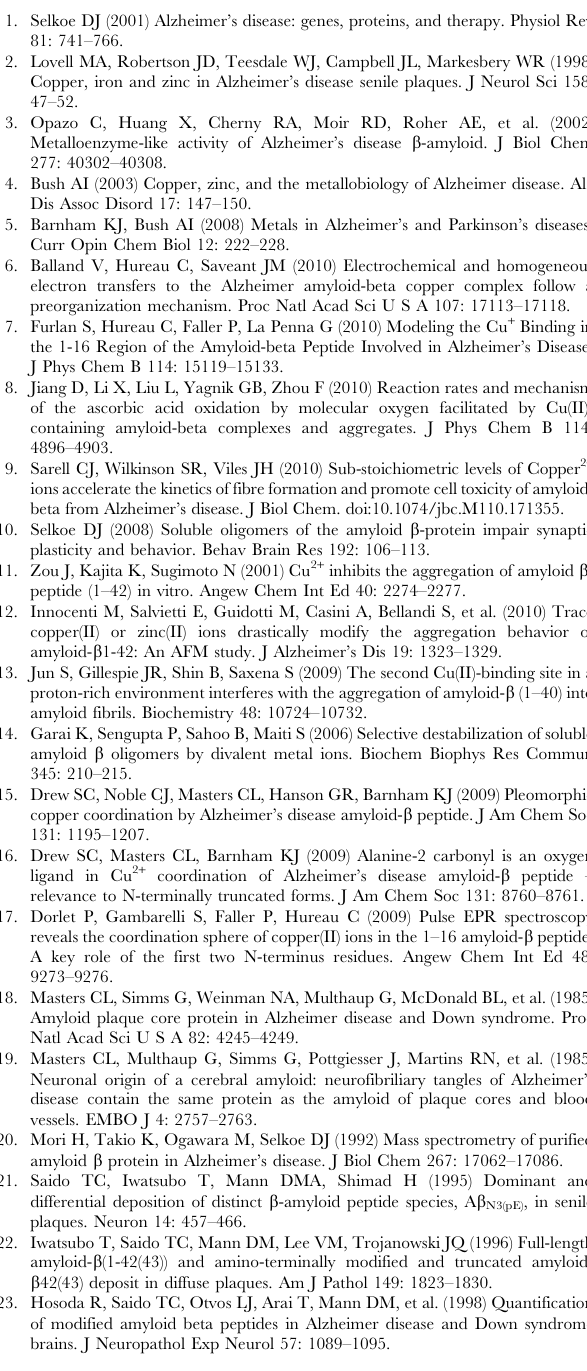
is raised. Dashed vertical lines identify the approximate position of the resolved A || ( 65 Cu) resonances of the low and high pH modes. (TIF) Figure S3 X-band HYSCORE spectra ( t =144 ns) of Cu 2 + /A b 3–16 and Cu 2 + /A b 3[pE]–16 analogues (0.9 equiv 65 CuCl 2 ), obtained at 3150 G and 3370 G (near g H ). Spectrum in (g) was acquired with a smaller number of data points in the time domain compared with the rest of the data set.